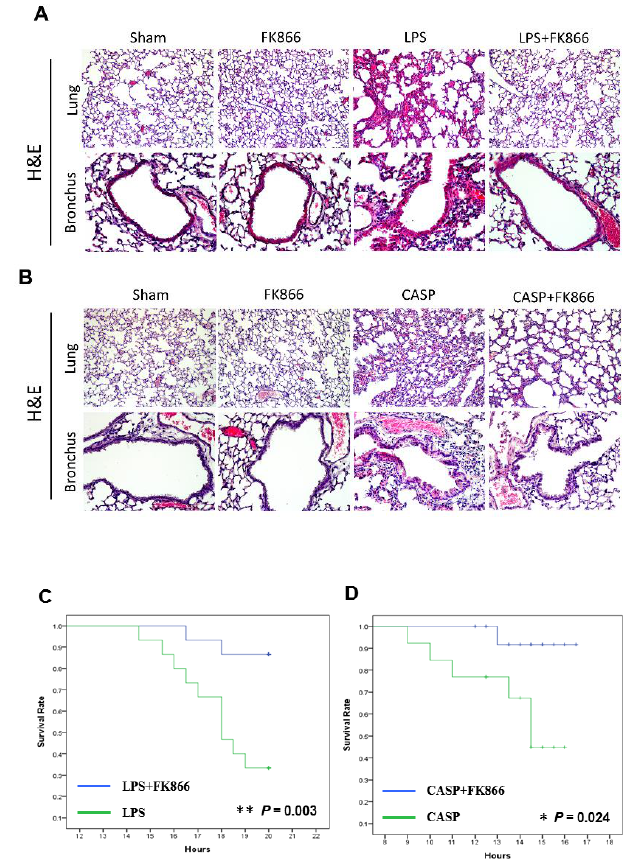
Figure 2. FK866, a visfatin inhibitor, decreased acute lung injury and increased survival in LPS and CASP ALI mouse models. ( A , B ) Histology of lung tissues in mice treated with LPS alone, CASP alone, or co-treatment with FK866, determined by H&E staining. Sham mice show normal lung tissue and LPS- or CASP-treated mice show injuries in lung tissue, including fluid-filled alveoli, septal thickening, and interstitial lymphocytic and neutrophilic infiltration. (100 × amplification). ( C , D ) Survival rate in mice treated with LPS alone, CASP alone ( n = 15), or co-treatment with FK866 ( n = 15) in ALI mouse model. *, p value < 0.05. **, p value < 0.01.